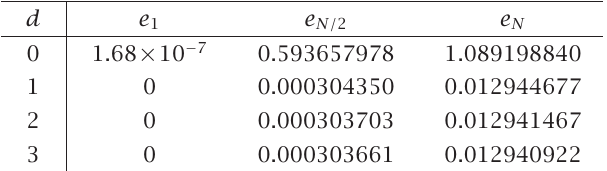
= 1 / 3 , c = 2 / 3 , c = 1 } ) 1 2 3